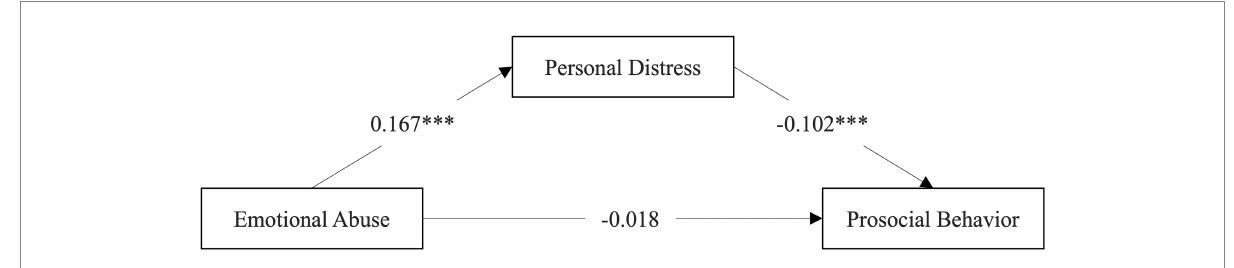
FIGURE 3 Personal distress mediates the association between emotional abuse and prosocial behavior. *** p